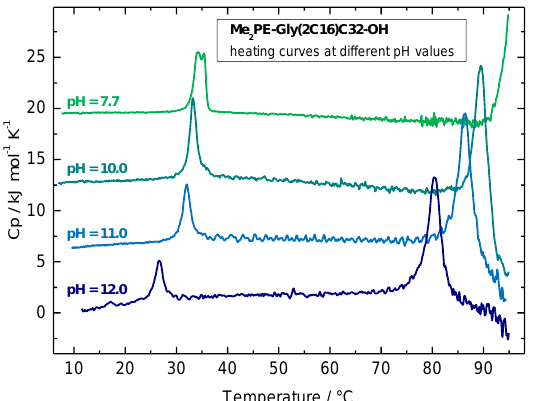
Figure 4. DSC heating curves of a Me 2 PE-Gly(2C16)C32-OH suspension ( c = 1 mg mL −1 ) in variable buffer solutions at different pH values: phosphate buffer at pH = 7.7 (green line); carbonate buffer at pH = 10.0 (cyan line), pH = 11.0 (blue line), and pH = 12 (dark blue line). The heating rate was 60 K h −1 . The curves are shifted vertically for clarity.